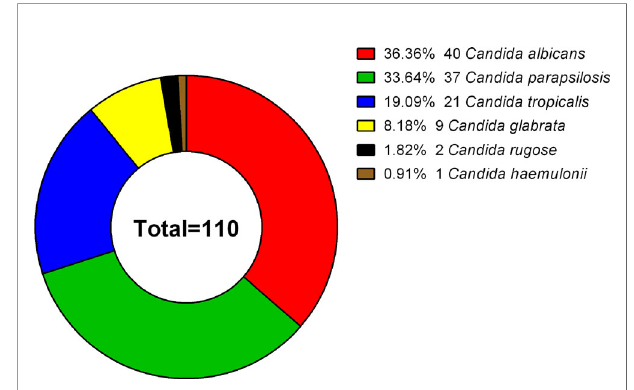
FIGURE 1 | Species distribution of 110 clinical isolates. The 110 Candida strains analyzed included 40 C . albicans (36.36%), 37 C .